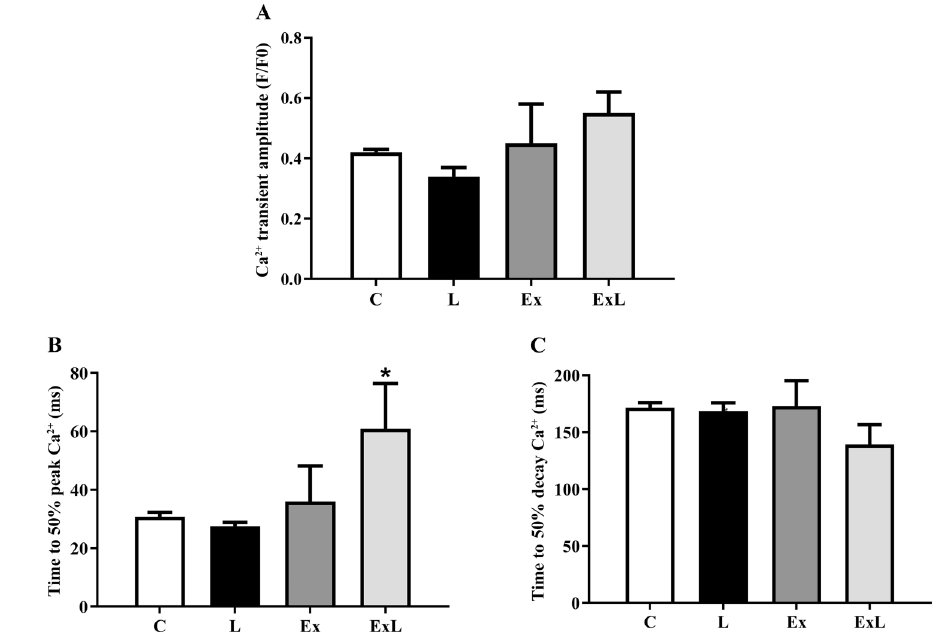
Figure 6. Cardiomyocyte calcium transients. Data are reported as mean ± SEM. C: control (n=4; 25 cells); L: low-dose administration of L-NAME (n=4; 17 cells); Ex: chronic aerobic exercise (n=4; 14 cells); ExL: chronic aerobic exercise and low-dose administration of L-NAME (n=5; 7 cells). A , Ca 2 + transient amplitude. B , time to 50% peak Ca 2 + , and C , time to 50% decay Ca 2 + . The records were obtained from electrical stimulation with 1 Hz. *P o 0.05 ExL vs L (two-way ANOVA followed by Tukey ’ s post hoc